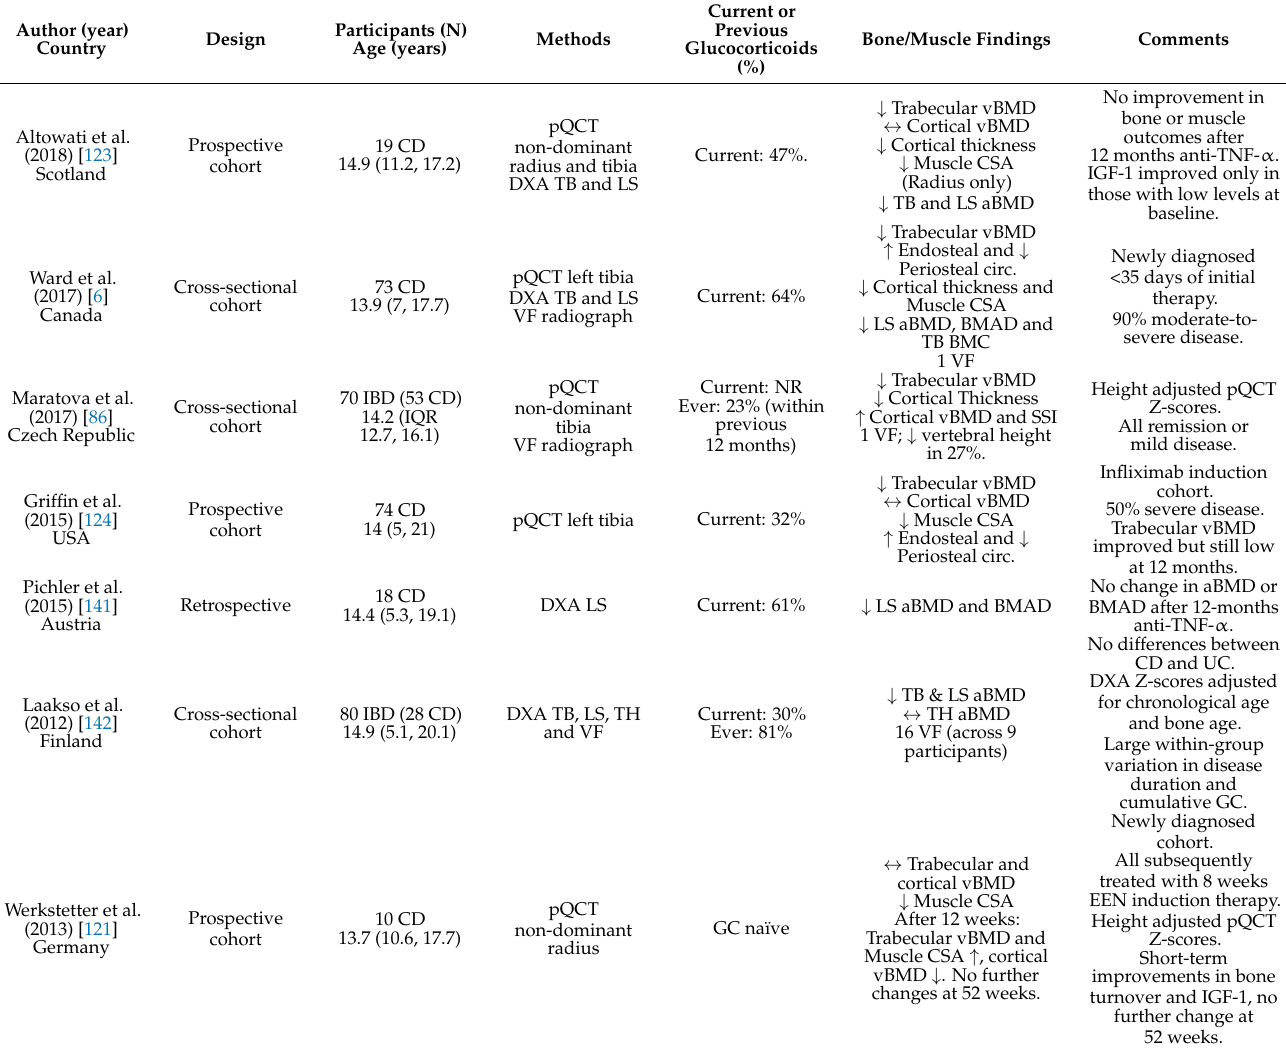
Table 1. Summary of major clinical bone imaging studies in paediatric